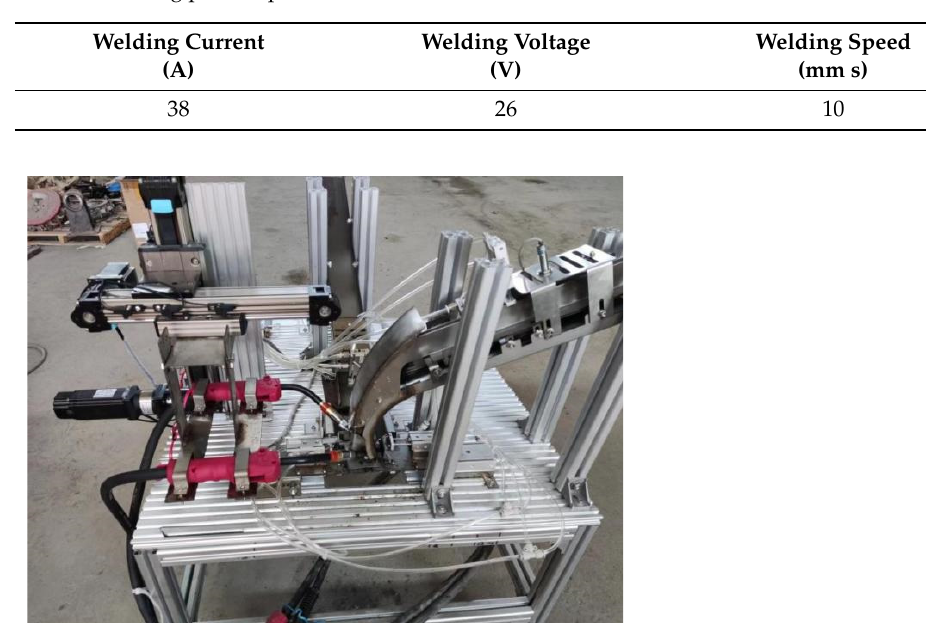
Figure 17. Cotton seeder duckbill welding robot.